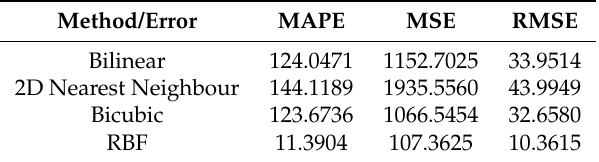
Table 1. Comparison of the performance of interpolation